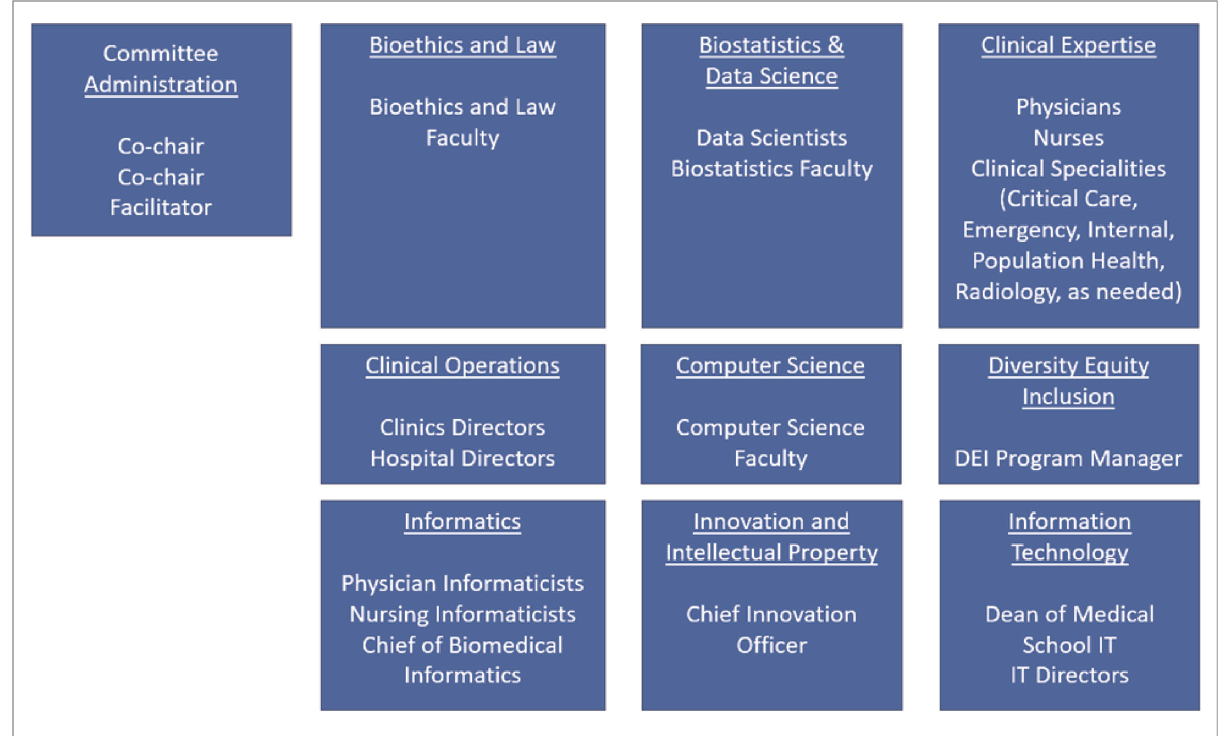
FIGURE 1 Clinical AI and predictive analytics committee composition with participants by role by respective disciplines.